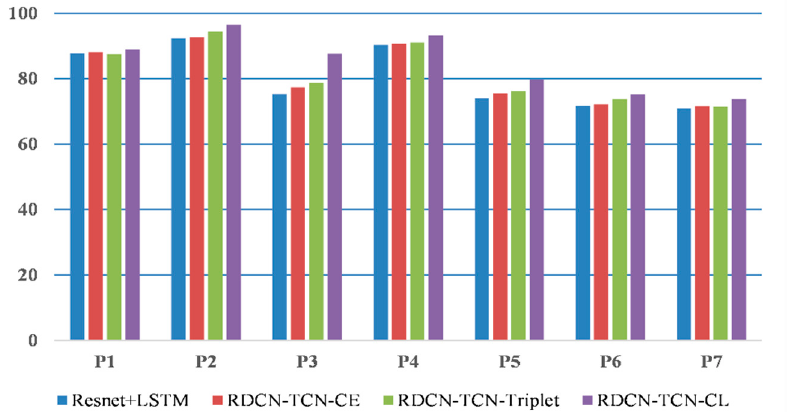
Figure 9. Comparison of the baseline on Cholec80 dataset. We report average F1 scores for each phase, P1 to P7.